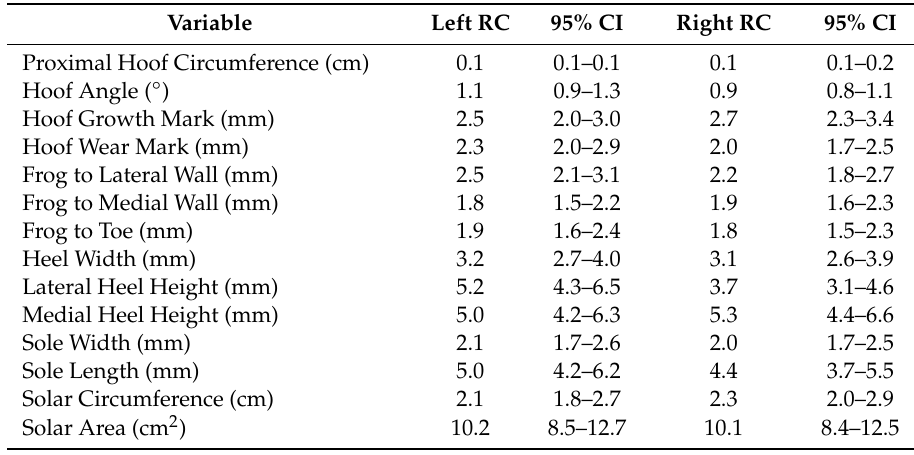
Table A1. Repeatability of the measurements for the left and right front hooves ( n = 50). Results